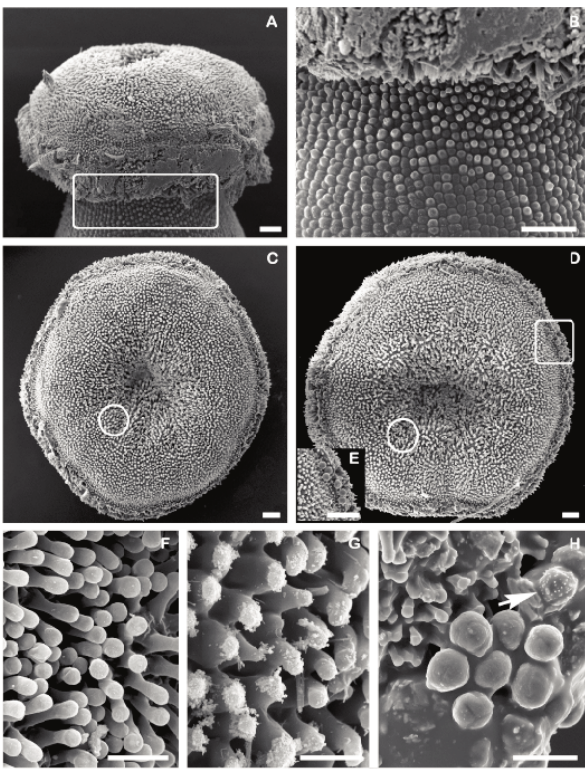
Fig. 2 -SEM micrograph of the pistil of B. microphylla G. Forst. A, stigma of a flower on stage 59; B, detail of box in the pic- ture A, periphery of the upper end of the ovary with glands; C, stigma front view shown in A; D, stigma front view shown of a flower on stage 60; E, detail of box in the picture D, long hairs peripheral stigma with pollen grains attached; F, detail of circle in the picture C, epidermal cells of stigma; G, detail of circle in the picture D, active secre- tions glands; H, mixture of pollen grains wrapped in stig- matic mucilage, arrow points to a grain of foreign pollen. Bars: A-E =100 µm; F-H= 50 µm.